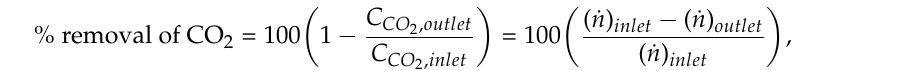
Figure 1. Illustration of flow patterns of a gas-liquid HFMC for post-combustion carbon capture (PCC) ( a ) counter-current flow, ( b ) cross-flow, and ( c ) co-current flow. A common performance metric for HFMCs is the percentage removal rate, defined as follows